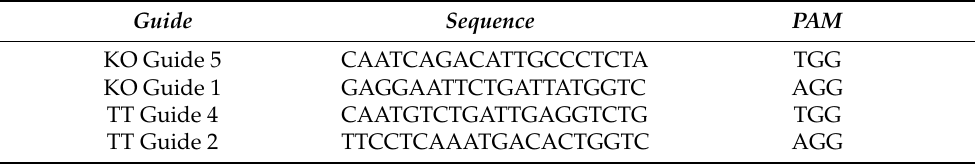
Table 2. gRNAs used in the HepG2 cell lines (KO gRNAs, TT gRNAs). Guide Sequence PAM KO Guide